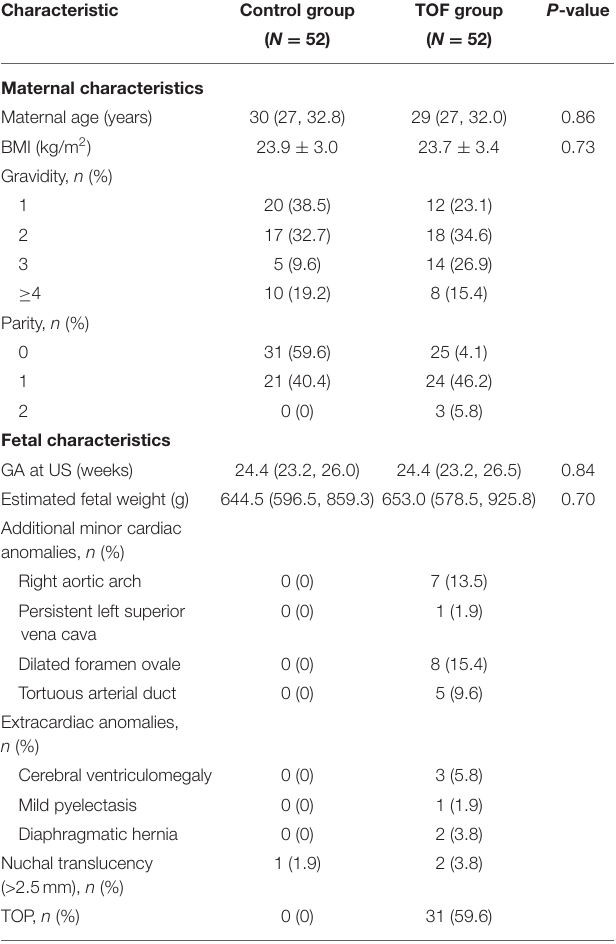
TABLE 1 | Baseline characteristics of the fetuses with TOF and normal controls. Characteristic